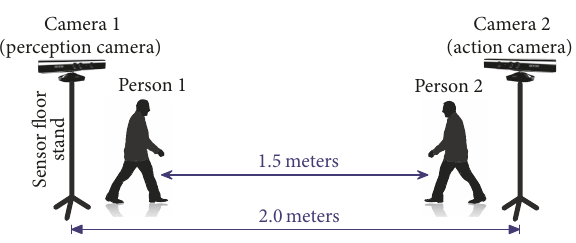
Figure 6: Settings for training data